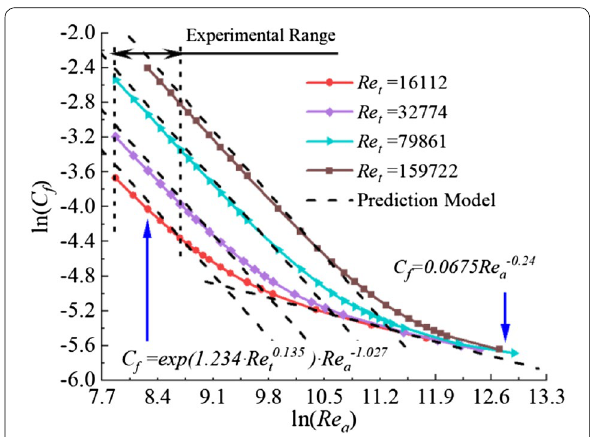
Figure 12 Simulated and empirical models over a vast range